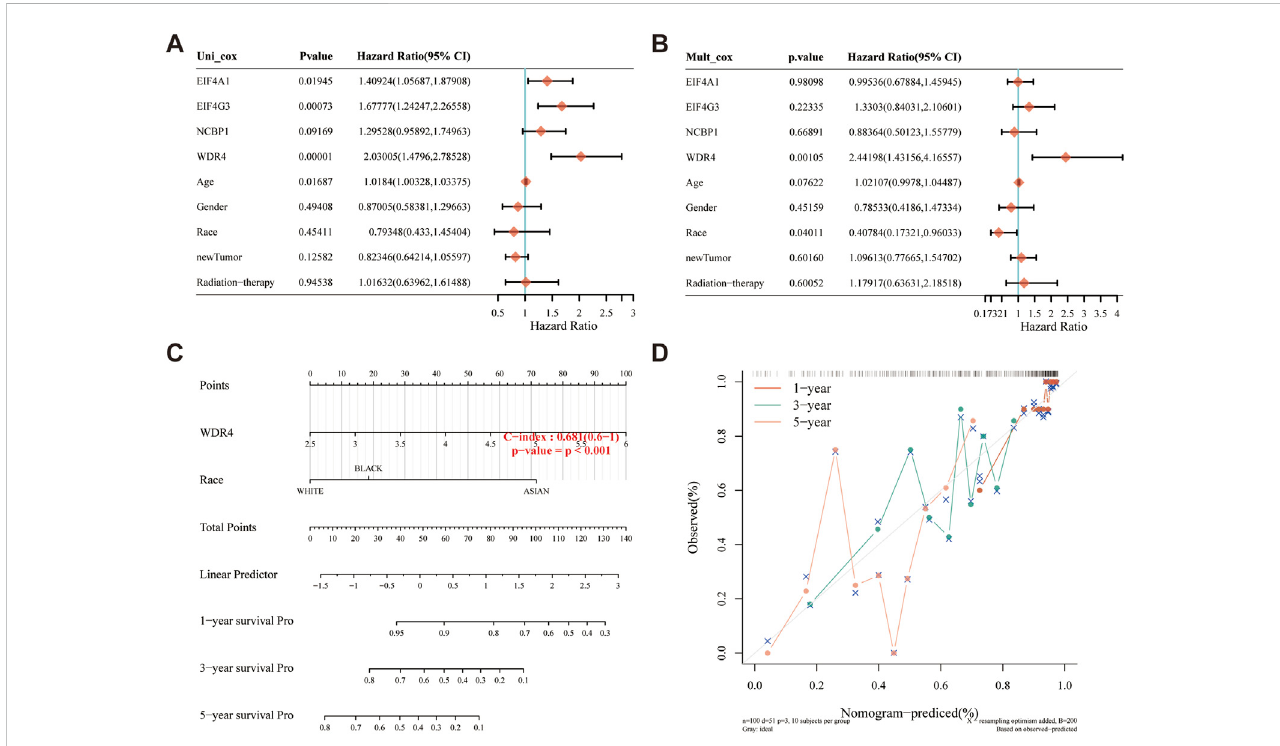
FIGURE 8 Construction of a predictive nomogram. (A, B) Hazard ratios and p -value of the constituents involved in univariate and multivariate Cox regression analysis considering the clinical information and prognostic m7GRGs in sarcomas. (C) Nomogram to predict the 1-year, 3-year and 5-year OS rate of SARC patients. (D) Calibration curve for the OS nomogram model in the discovery group. The dashed diagonal line represents the ideal